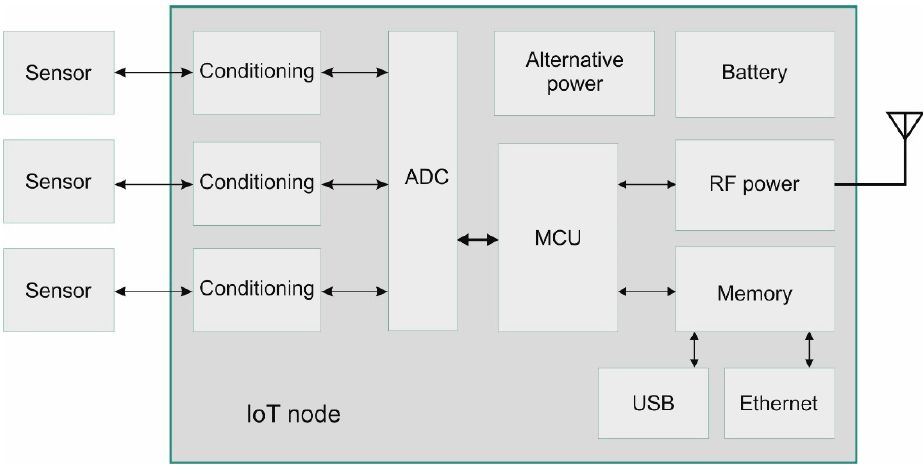
Figure 2. IoT node. Figure 2. IoT